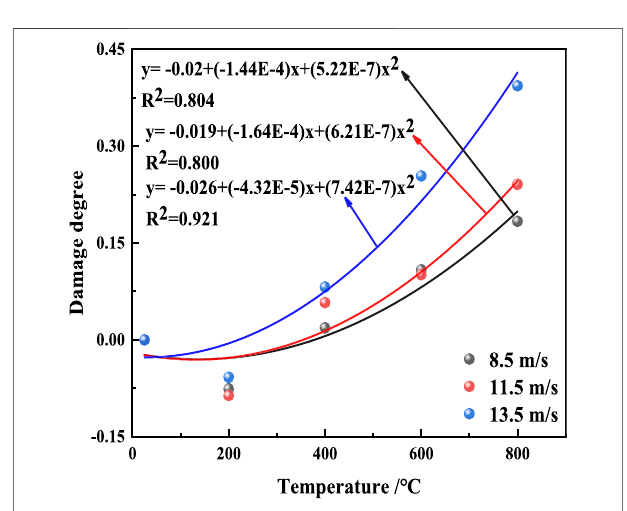
FIGURE 11 | Temperature damage degrees in different working